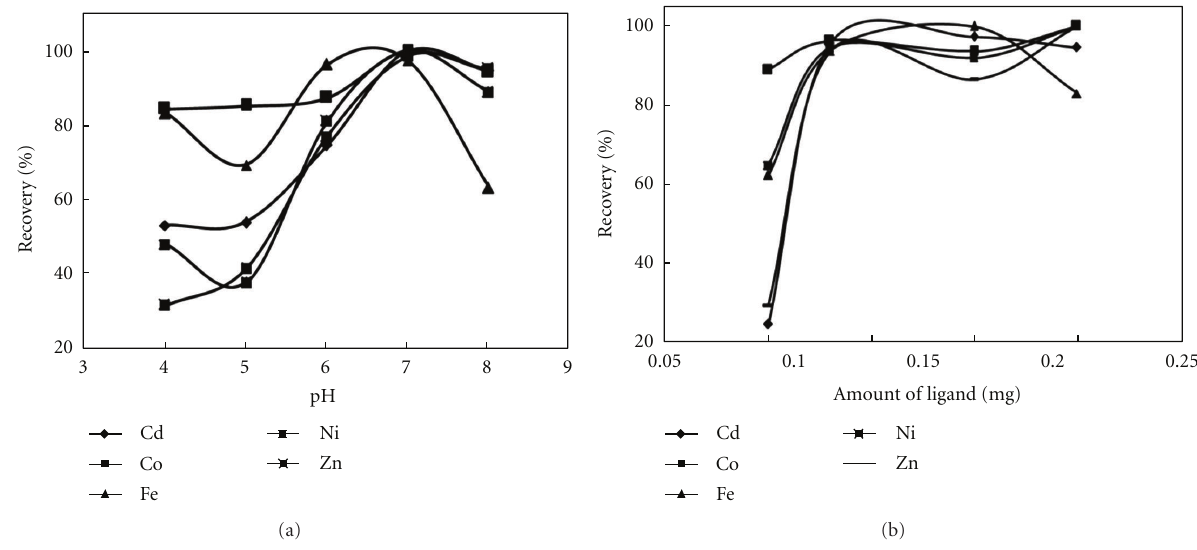
Figure 5: (a) E ff ect of pH on recoveries of analyte ions ( N = 3), (b) e ff ect of amount of ligand on recoveries ( N = 3).